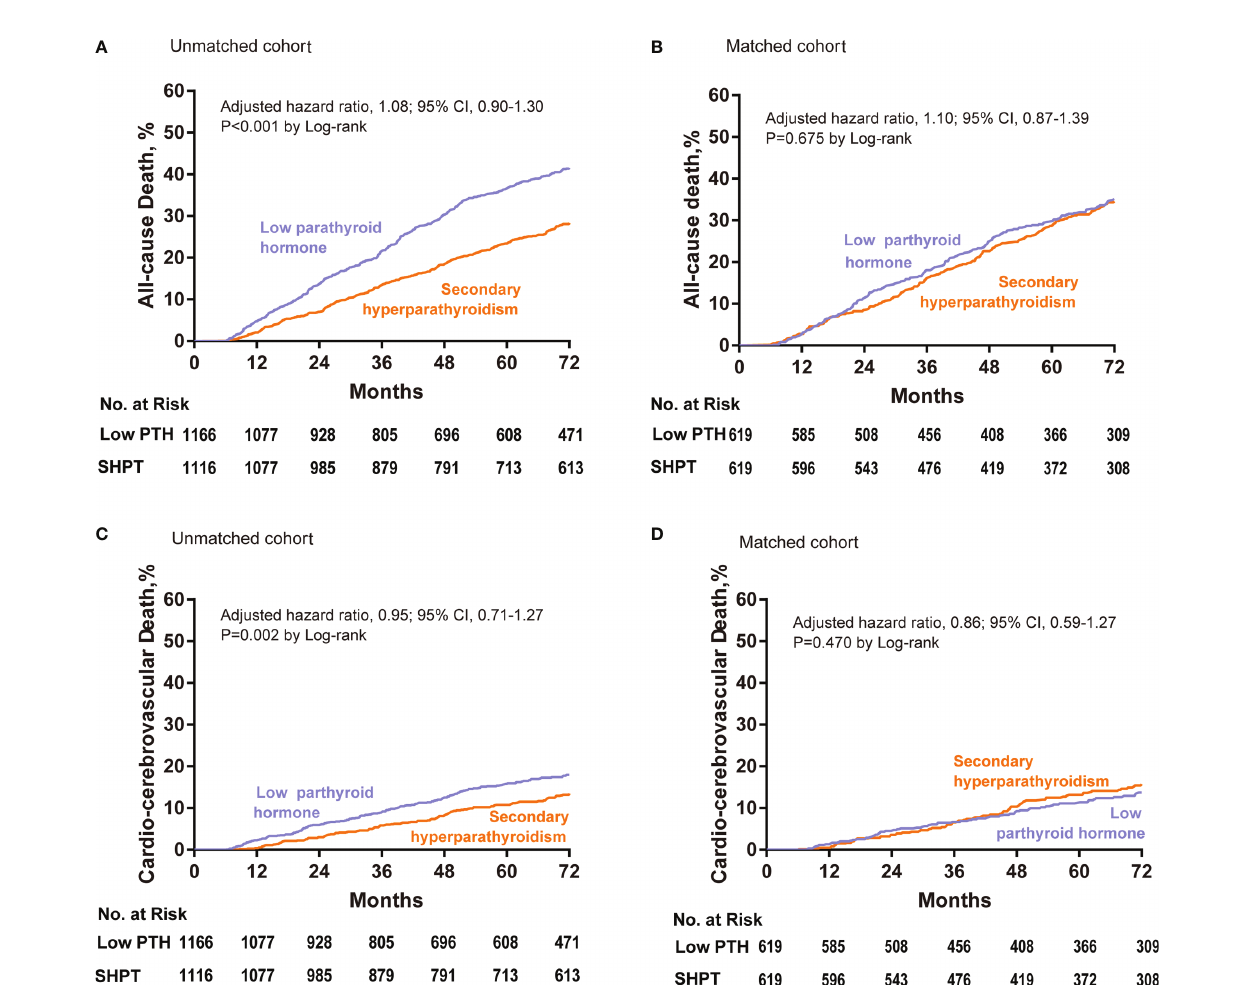
FIGURE 2 | Cumulative event rates at 72 months for all-cause death among patients with low PTH and SHPT in the unadjusted (A) and propensity-matched cohorts (B) . Cumulative event rates at 72 months for cardio-cerebrovascular death among patients with low PTH and SHPT in the unadjusted (C) and propensity- matched cohorts (D) . Hazard ratios are based on multivariable Cox regression analyses. PTH, parathyroid hormone; SHPT, secondary